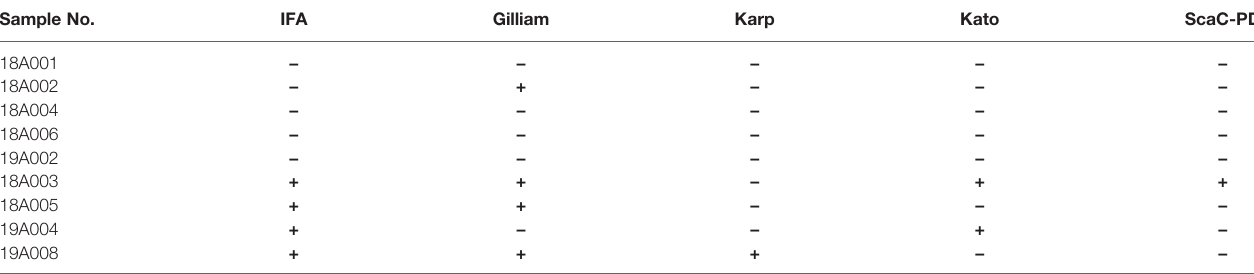
TABLE 4 | A pilot study using our cell-based ELISA system to diagnose human patients ’ serum samples. Sample